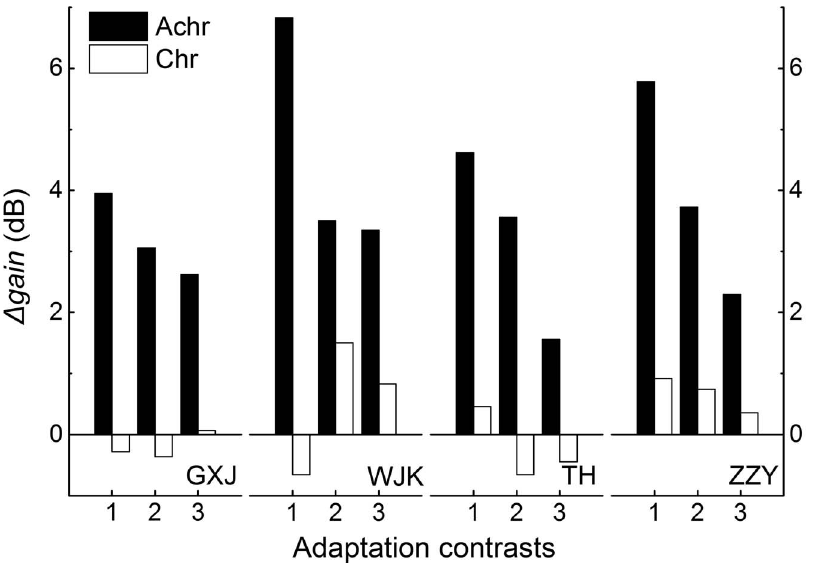
Figure 3. Saccadic suppression quantified with D gain. Chromatic and achromatic are abbreviated as chr. and achr. Three adaptation contrasts are ordinal-indexed for illustration. D gain shows a clearer and more robust decreasing tendency in achromatic condition (filled) than that in chromatic condition (unfilled) as contrast adaptation is intensified. doi:10.1371/journal.pone.0086542.g003 thresholds of saccade and fixation were tested based on the same population contrast response property. The difference between the two thresholds, i.e. saccadic suppression, could then be regarded as the influence posed on contrast gain by saccade. Thus the interaction between saccadic suppression and contrast adaptation can be interpreted like this: saccadic suppression is produced on the basis of different contrast gain baselines that have been modified by contrast adaptation.